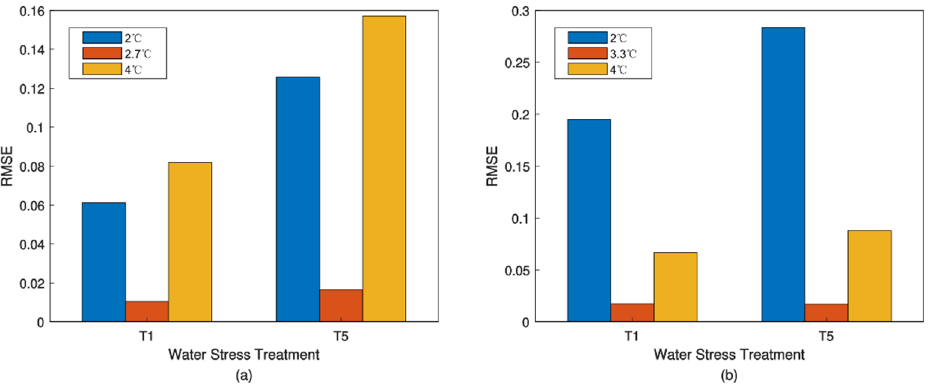
Figure 9. Comparison of RMSE results of different upper limits of Δ T: ( a ) comparison of RMSE in 2.7 °C; ( b ) comparison of RMSE in 3.3 °C.